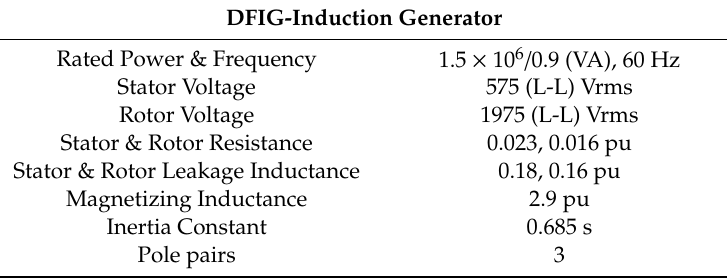
Table A1. Simulation Data for DFIG Induction Generator.